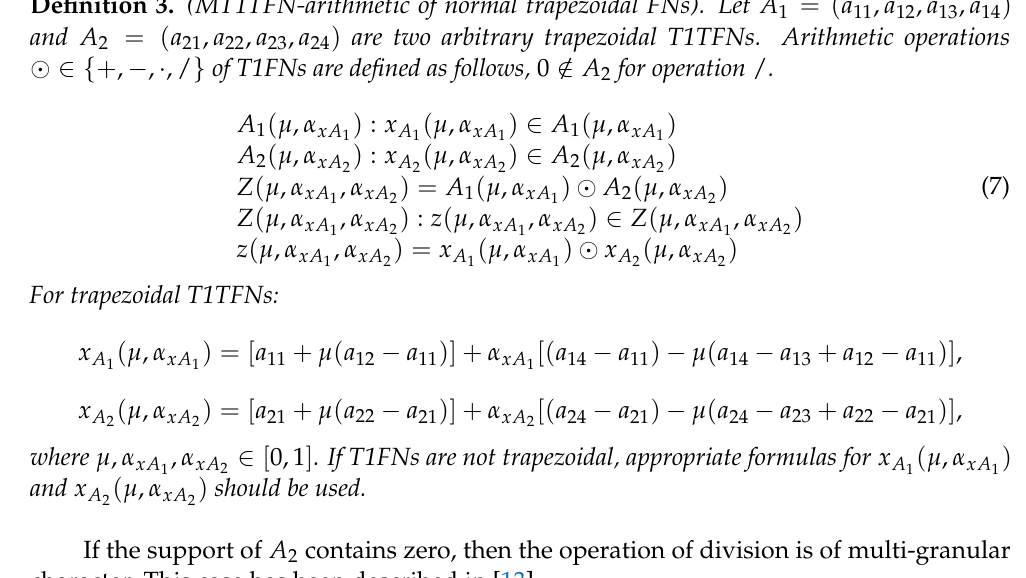
, α xA , and µ allow us to specify every point 2 1